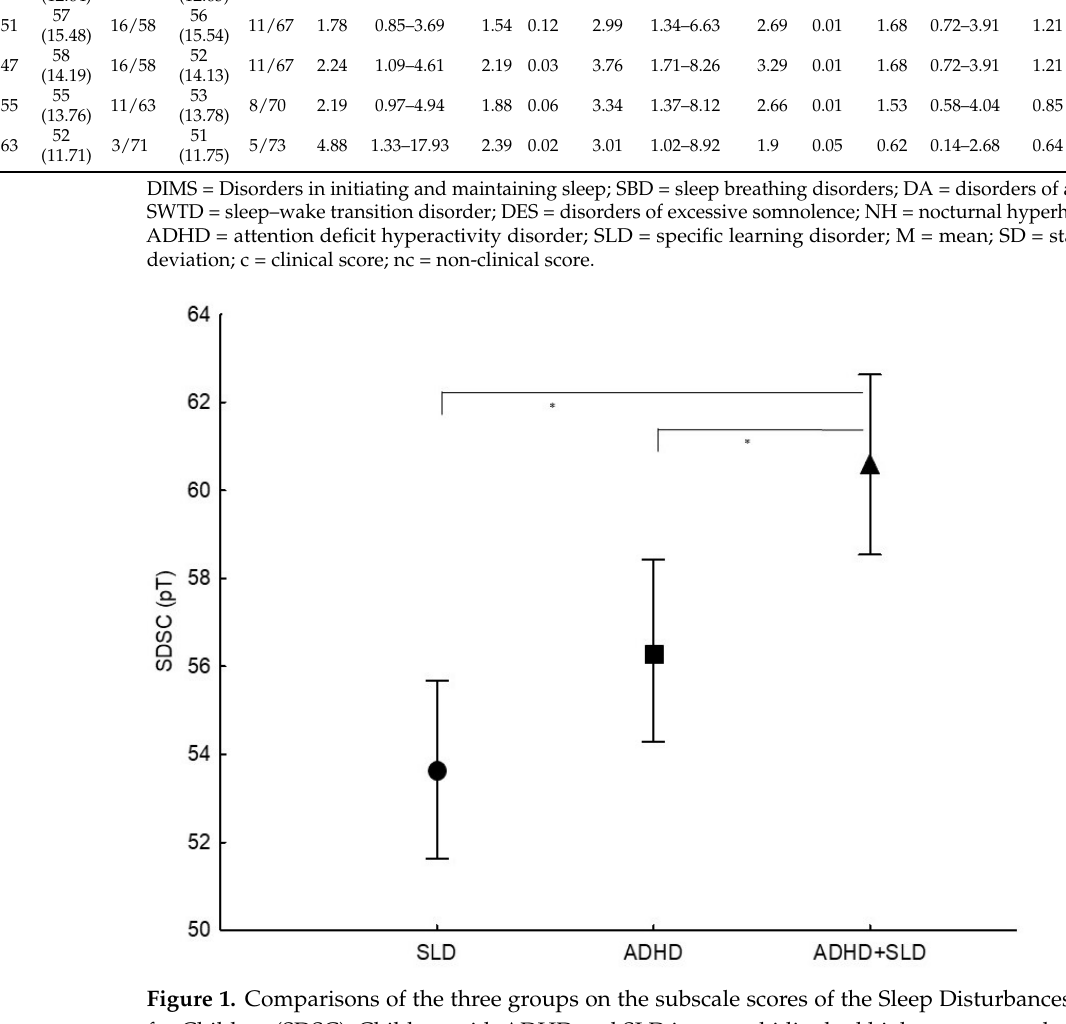
Table 2. Means, standard deviations in SDSC subscales, and p -values of their comparisons.